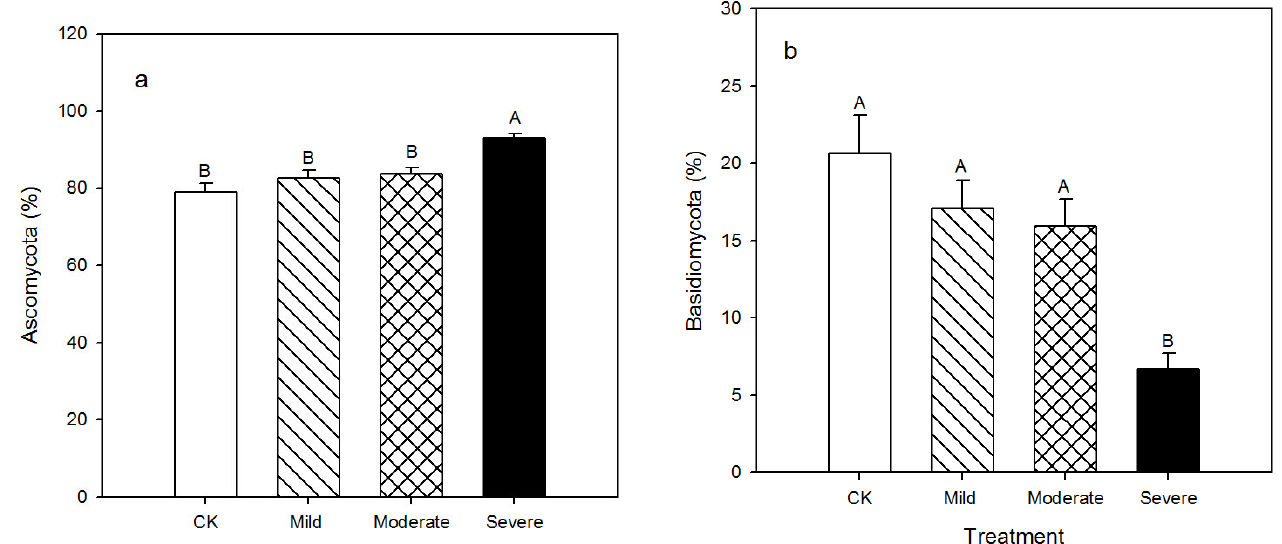
Figure 5. Examples of various responses of endophytic fungi to salt stress. The phyla included Ascomycota ( a ) and Basidiomycota ( b ). Values are means ± SEs. Significant differences between different levels of salt stress are indicated by uppercase letters ( p < 0.05). Table 3. The relative abundances (%) of the families of different fungi under salt stress.